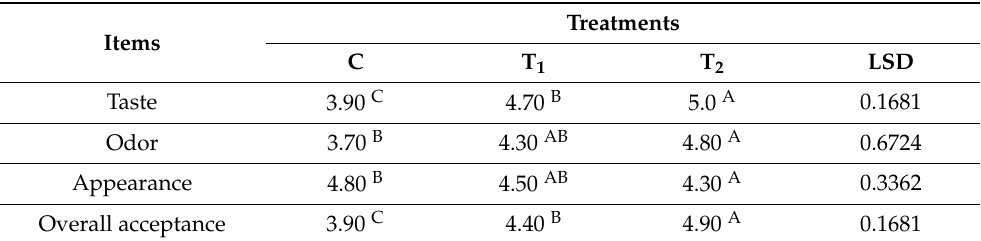
Table 4. Sensory properties of a yogurt drink fortified with golden berry juice on the first day of